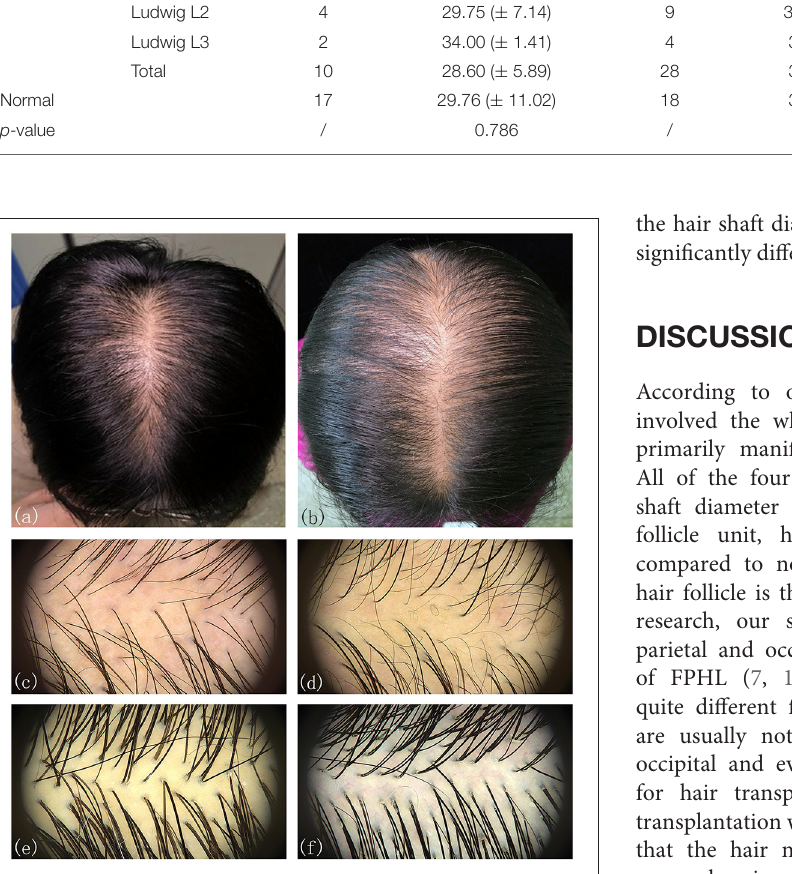
FIGURE 2 | Typical clinical and trichoscopic feature (vertex) of male FPHL (a,c) and female FPHL (b,d) patients, compared with normal male (e) , and female (f)